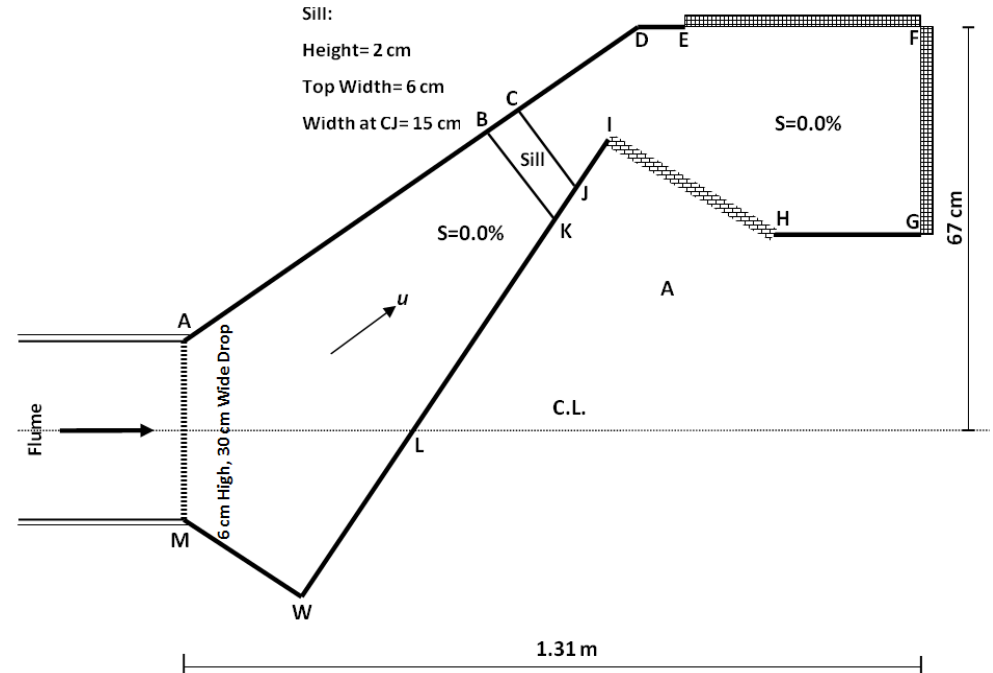
Figure 7. Extent and dimensions of the physical